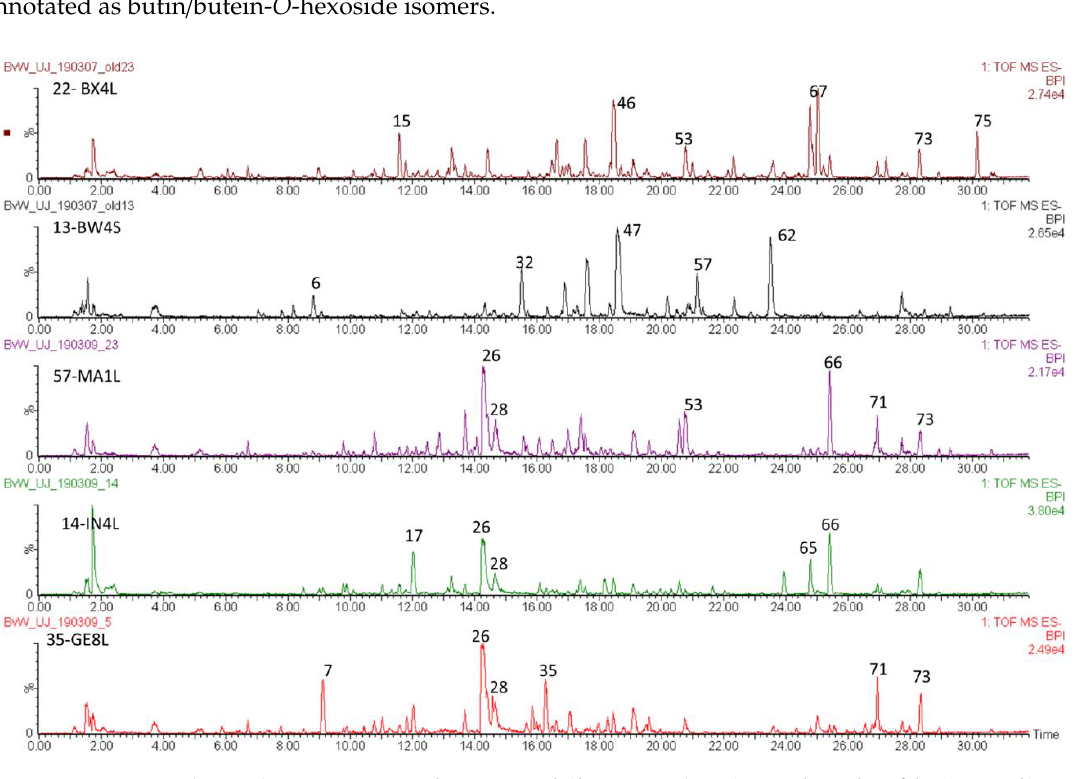
Figure 1. Total ion chromatograms of extracts of (from top down): Cyclopia buxifolia (Burm.f.) Kies leaves from Jonkershoek (BX4L); Cyclopia bowieana Harv. stems from Ruitersberg (BW4S);